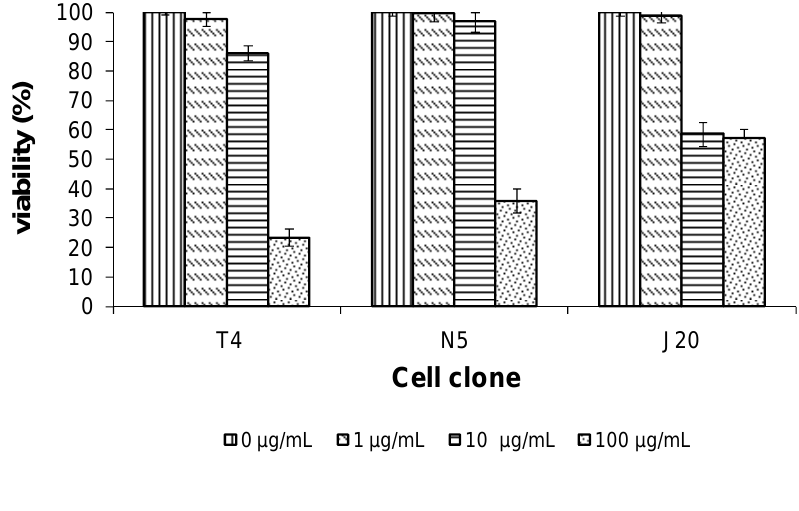
Figure 8. Effect of the lectin from tepary beans on mouse 3T3 fibroblast cell clones. Cell clones were exposed to the indicated concentration of tepary bean lectins for 24 h, and after incubation, viability was determined employing the MTT